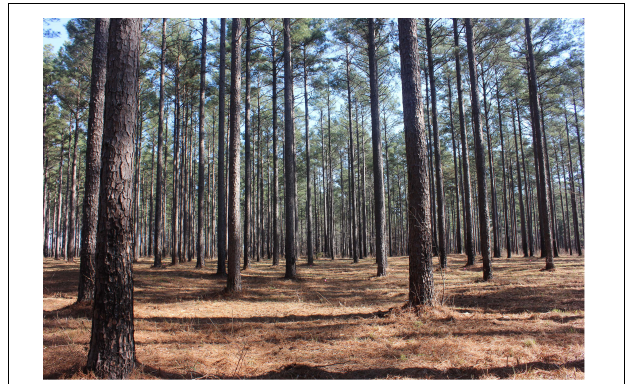
FIGURE 4 | Picture of the 1969 outplanting of the CEF superior pine progeny tests taken in January 2017 showing a typical view of the loblolly as they currently